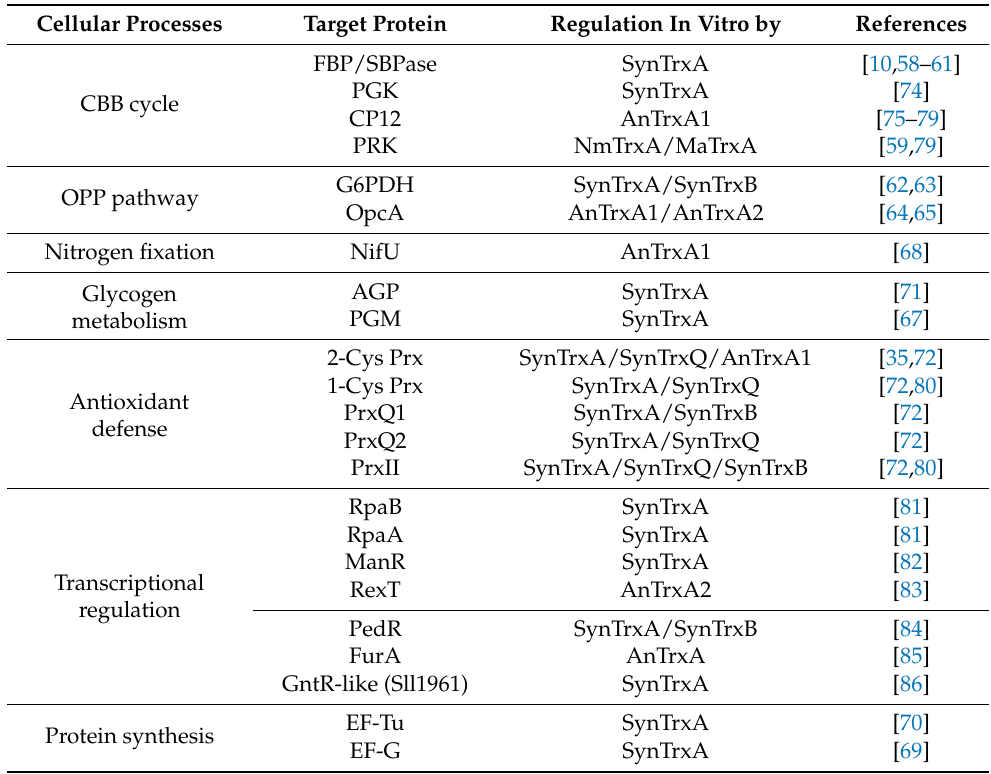
Table 1. Trx target proteins described in vitro. Proteins are indicated with abbreviations for the name of the organism: Synechocystis TrxA (SynTrxA), Synechocystis TrxB (SynTrxB), Synechocystis TrxQ (SynTrxQ), Anabaena TrxA1 (AnTrxA1), Anabaena TrxA2 (AnTrxA2), Nostoc muscorum TrxA (NmTrxA), and Microcystis Aeruginosa TrxA